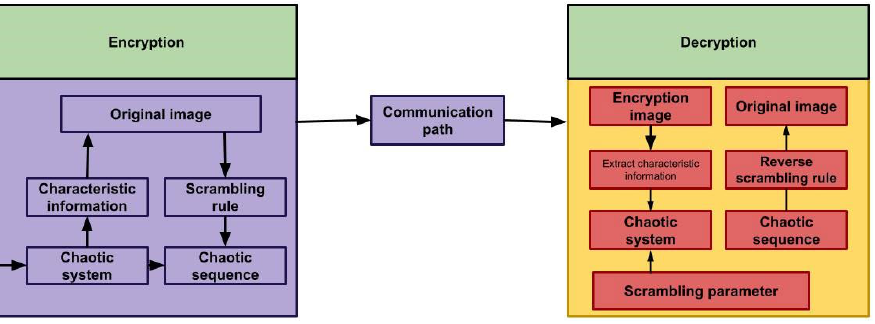
Figure 3. Schematic diagram for the chaos-based scrambling algorithm. Step 1. Calculate the hyperchaotic system’s generated random sequence using Equa- tions (6) and (7).